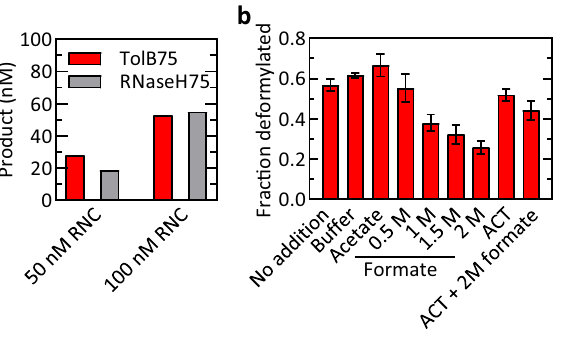
Figure 4. Reversal of deformylation. ( a ) End level of deformylation at different RNC concentrations. TolB75- RNC and RNaseH75-RNC were incubated with PDF (10 nM) for 20 min at 37 °C. ( b ) Reversibility. After incubation of TolB75-RNC (50 nM) with PDF (1 µM) for 10 min (‘No addition’), additions were made as indicated. The PDF inhibitor actinonin (ACT; 2 mM) was included where indicated. Deformylation levels measured after 30 min further incubation are depicted. Error margins represent the standard deviation of three independent experiments.